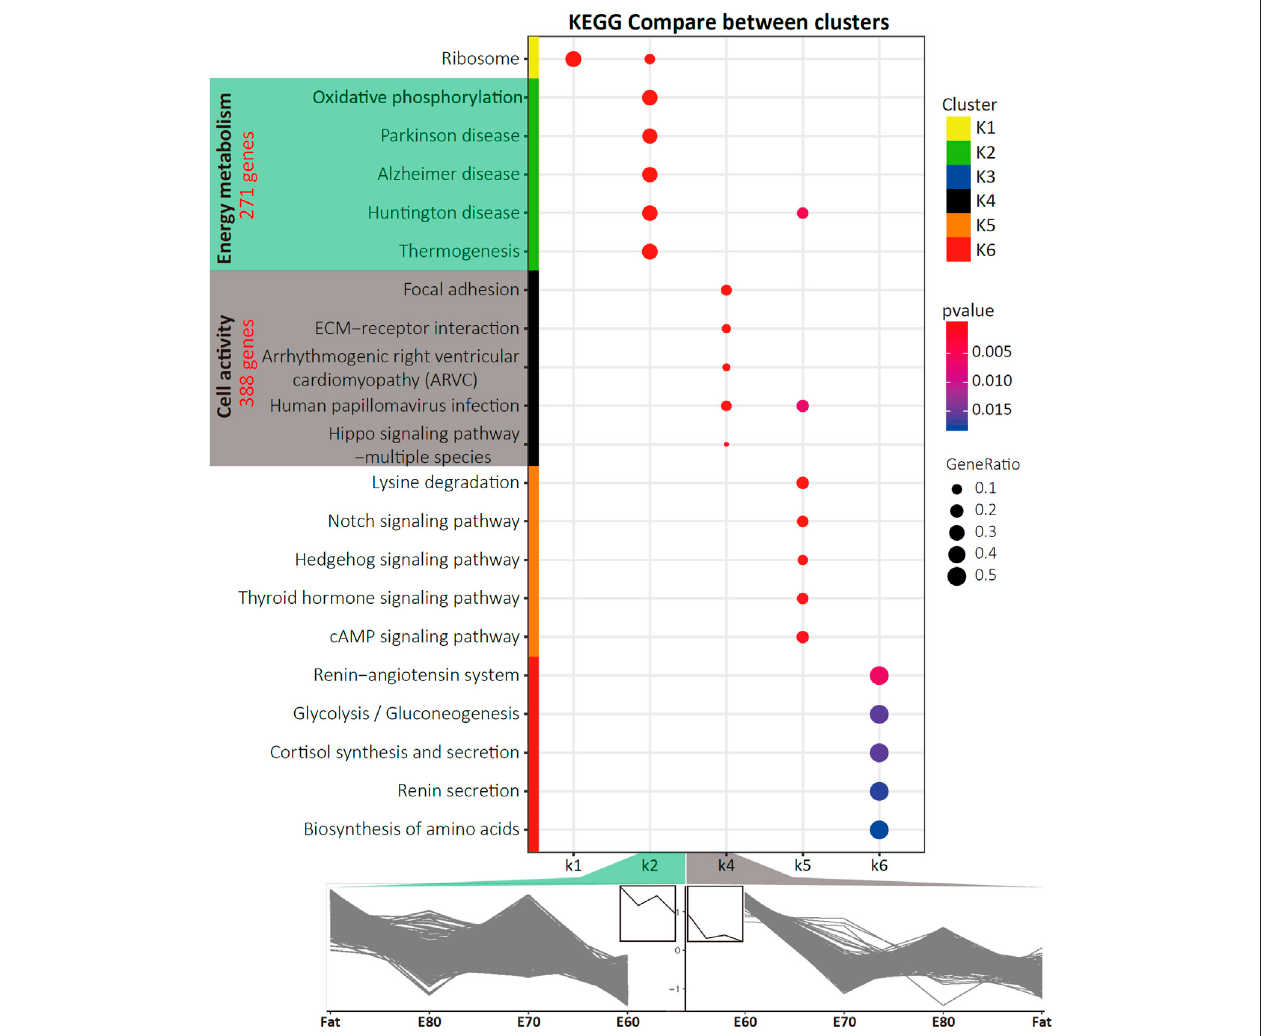
FIGURE2| TheKEGGpathways thatwerespeci fi callyenriched foreachcluster.Also shownisthegeneexpression timecoursetrendsfortheK2andK4clusters. Thepathwaysthatwerespeci fi callyenrichedinK2andK4weremainlyinvolvedinenergymetabolismandcellactivity.Thenumberofgenescontainedintwoclustersare indicated in